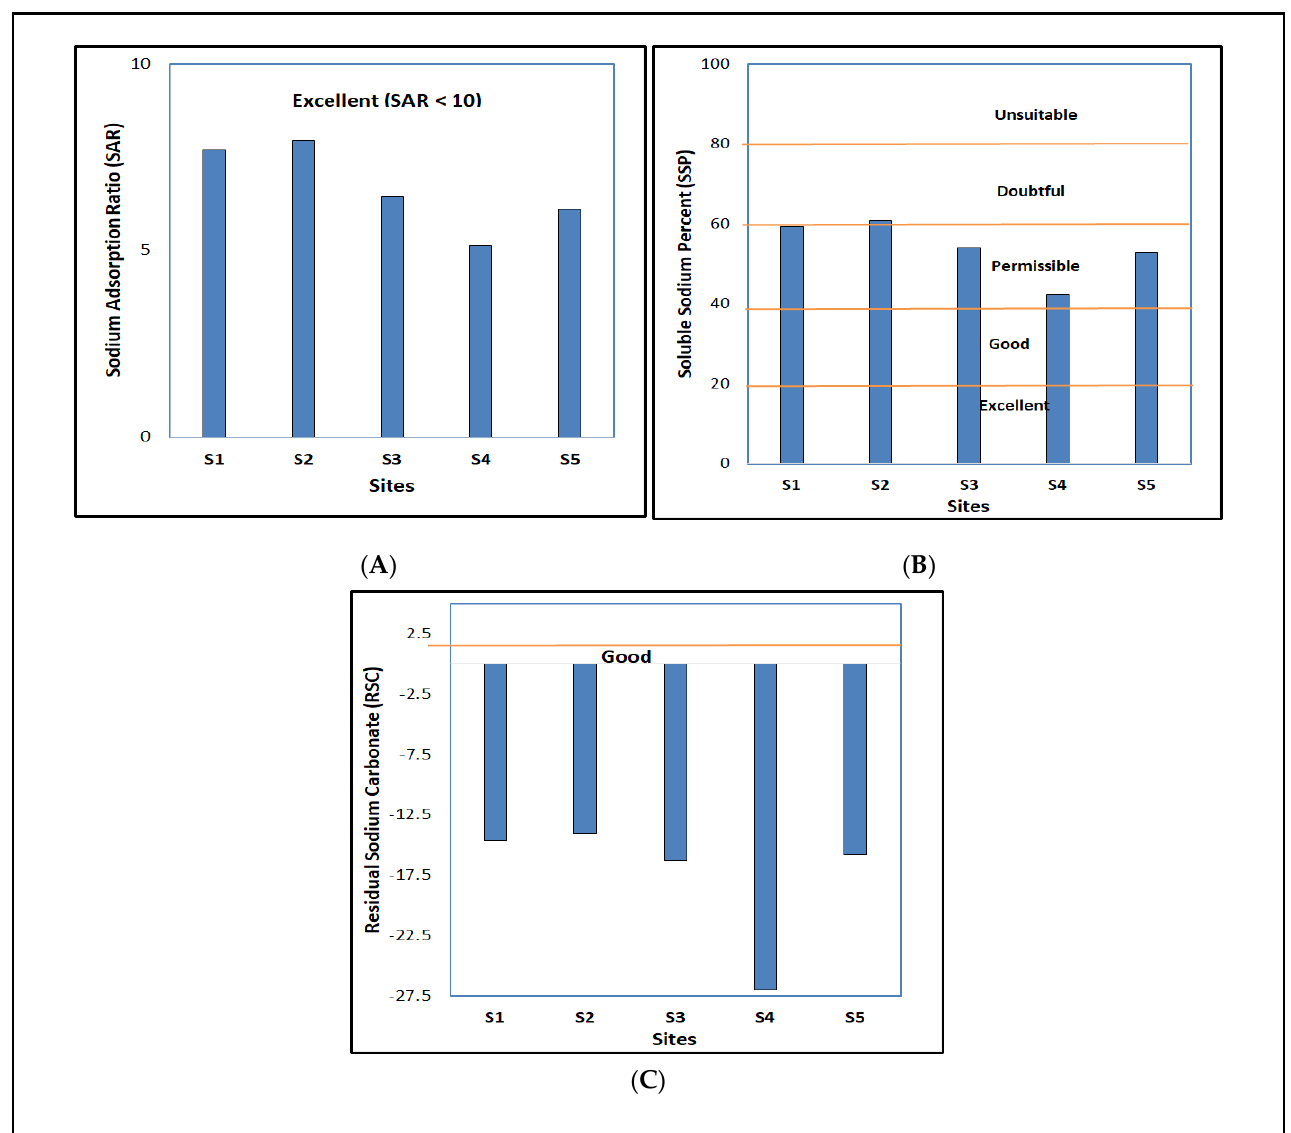
Figure 8. The sodium hazard for the groundwater samples. ( A ) Sodium adsorption ratio (SAR) < 10, excellent; ( B ) Soluble sodium percentage (SSP) < 60, permissible; ( C ) Residual sodium carbonate (RSC) < 1.25, Good.